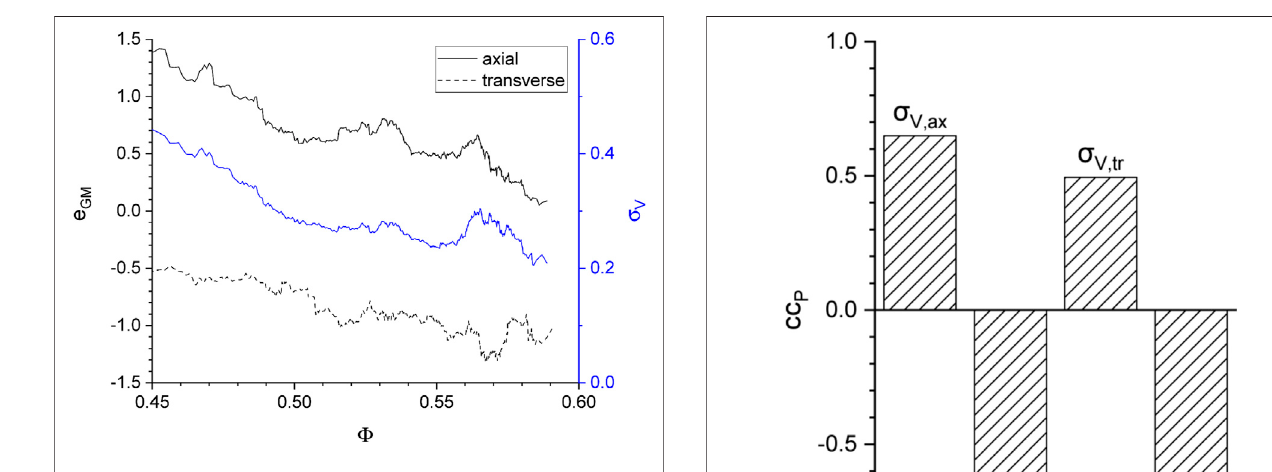
FIGURE 16 | Standard deviation of the Voronoi polygon areas σ V and normalized errors of axial and transverse fl ow.